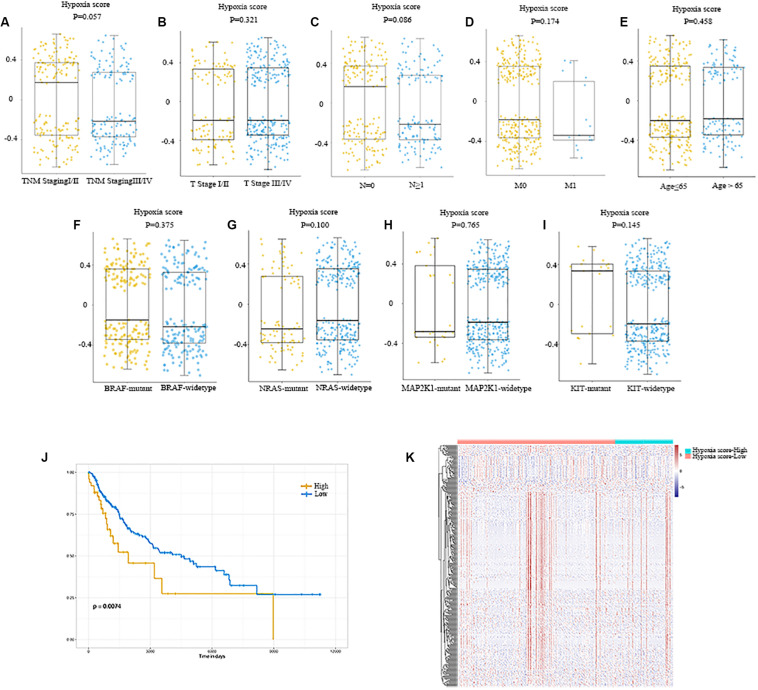
Distribution of hypoxia score in melanoma. (A) Distribution of hypoxia score of patients with different TNM staging. (B) Distribution of hypoxia score of patients with different T stage. (C) Distribution of hypoxia score of patients with or without lymph node metastasis. (D) Distribution of hypoxia score of patients with or without distant metastasis. (E) Distribution of hypoxia score of patients younger than 65 and those older than 65 years of age. (F–I) Distribution of hypoxia score of patients with BRAF mutant and BRAF wildtype, patients with NRAS mutant and NRAS wildtype, patients with MAP2K1 mutant and MAP2K1 wildtype, and patients with KIT mutant and KIT wildtype, respectively. (J) Patients were divided into high- and low-hypoxia score groups based on the cut-off value. Patients with a high hypoxia score showed a better prognosis compared to patients with a low score ((P) = 0.007). (K) Heatmap of the DEGs of high-hypoxia score group vs. low-hypoxia score group. p < 0.05, |fold change| ≥ 1.5. DEGs, differentially expressed genes.